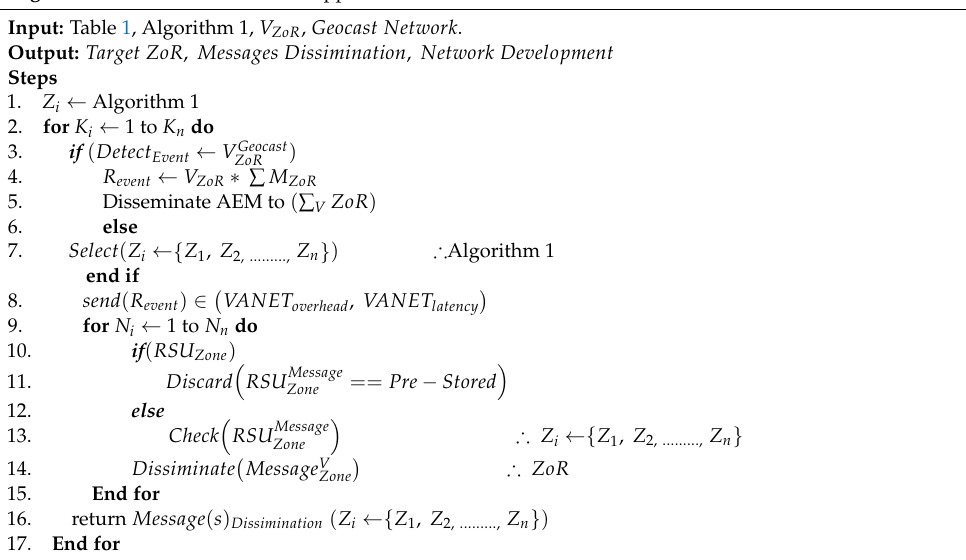
Algorithm 2: Data Dissemination